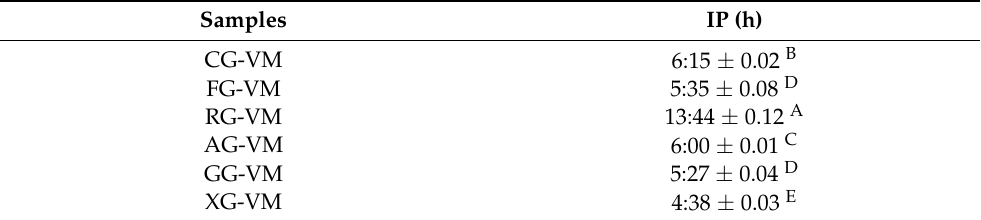
CG-VM: vegan mayonnaise contained chia seed byproduct gum, FG-VM: vegan mayonnaise contained flaxseed byproduct gum, RG-VM: vegan mayonnaise contained rocket seed byproduct gum, AG-VM: vegan